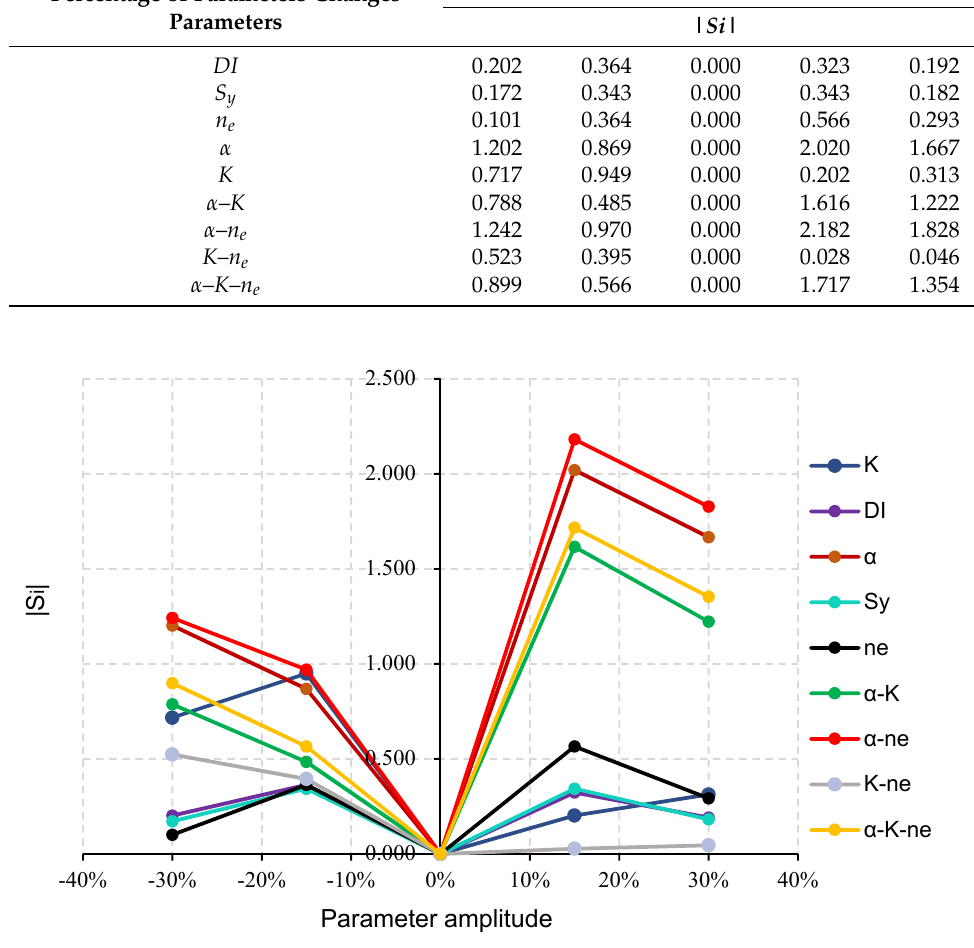
Figure 6. Parameter sensitivity analysis diagram.